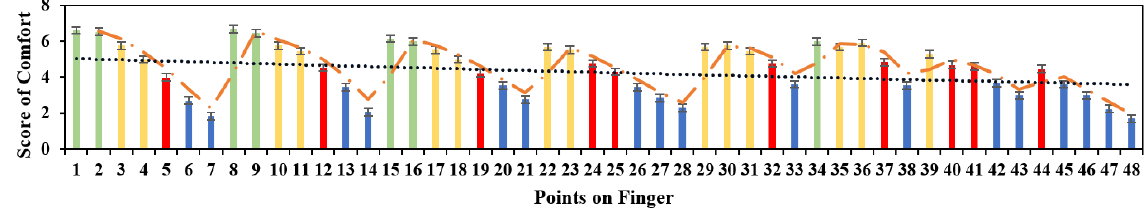
Figure 7. The scores of the level of comfort of the different areas of